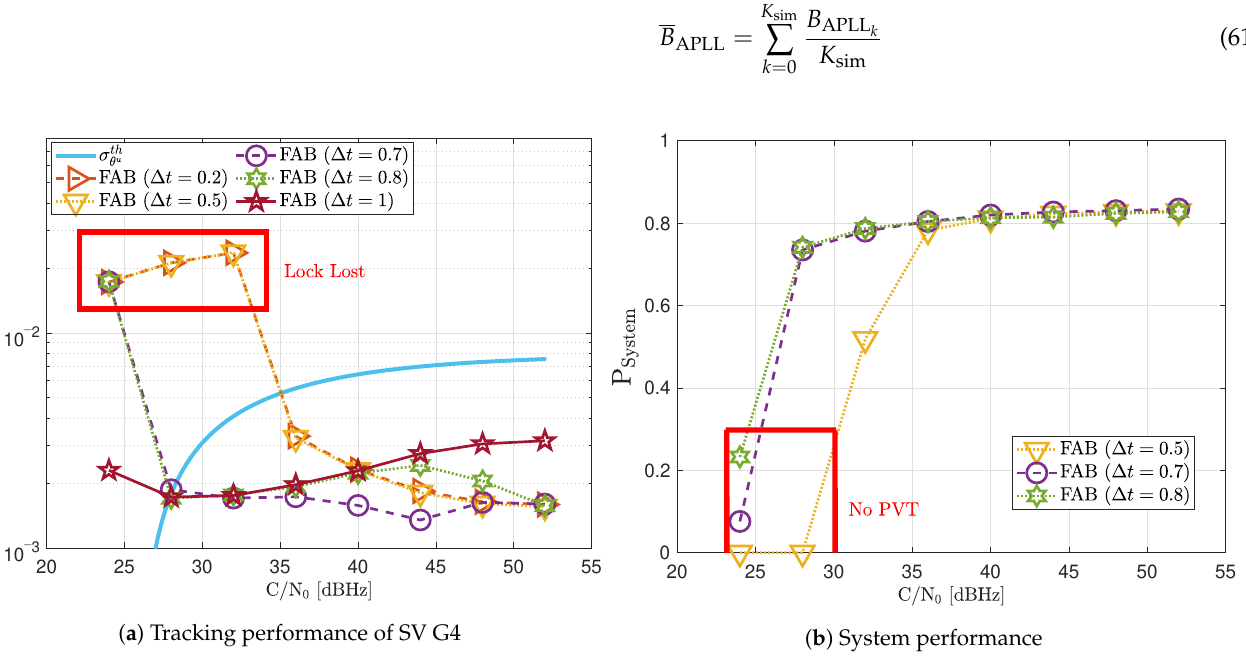
Figure 19. Static performance of FAB PLL at different C / N 0 levels.